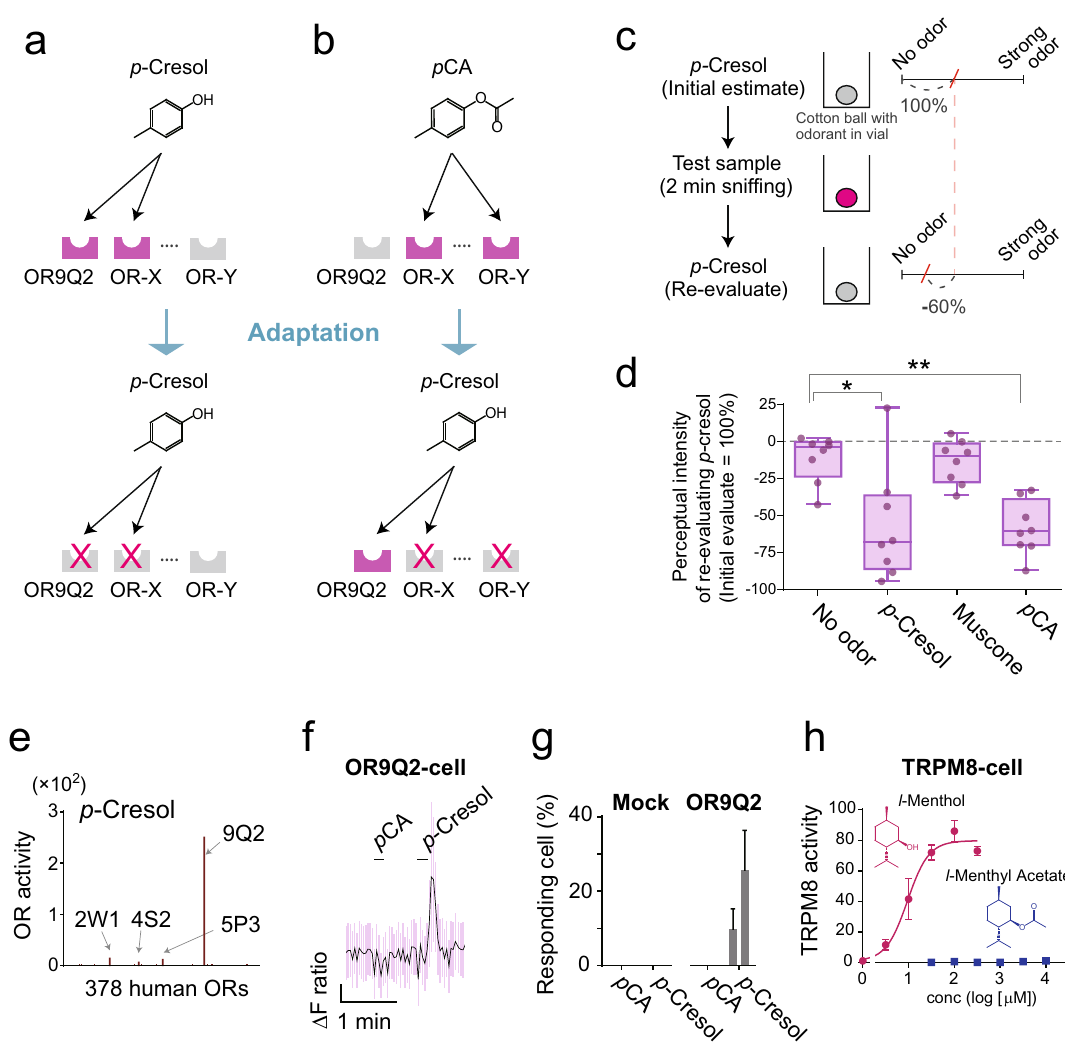
Figure 4. Effect of the enzymatic conversion on perception. ( a , b ) A model showing olfactory adaptation for p -cresol or p -cresyl acetate ( p CA) through activation and desensitization of a distinct subset of olfactory receptors (ORs). ( c ) The experimental adaptation scheme and sensory evaluation. Each subject evaluated the perceived intensity of the first bottle and the third bottle, both of which contain cotton balls saturated with p -cresol. The second bottle contained an adapting stimulus: distilled water (no odor), p -cresol, muscone, or p CA. Participants were asked to smell p -cresol and record their perceived intensity of the odor on a 95-mm scale, marked from no odor to strong odor. ( d ) Change in perceived intensity of p -cresol after prolonged exposure with each test sample (n = 8). Statistically significant changes in comparison with a control (no odor) were determined by one-way analysis of variance (ANOVA) with unequal standard deviation and Holm- Sidak’s multiple comparisons test. *, P = 0.0303; **, P = 0.0012. ( e ) Screening of human ORs for p -cresol. Each of the 378 ORs listed along the x-axis was expressed in HEK293T cells and stimulated with p -cresol (1 mM). OR activations were monitored using a CRE-regulated luciferase reporter gene assay. The y-axis indicates the fold increase of OR activity where a signal from stimulated cells is divided by that from non-stimulated cells expressing the same OR (mean values from two screening replicates). ( f , g ) Calcium imaging of OR9Q2 activation. ( f ) A representative response trace of responsive cells. The purple vertical lines around the trace represent the standard deviation from 50 cells. Horizonal lines above the trace indicate the duration of stimulations with 1 mM p CA and 0.3 mM p -cresol. ( g ) Proportion of responding cells to 0.3 mM or 1.0 mM of each odorant from three independent experiments (mean ± SE). ( h ) Dose–response curve of transient receptor potential melastatin 8 (TRPM8) activity with l -menthol and l -menthyl acetate. Calcium ion influx-dependent fluorescence in TRPM8 stably expressed in HEK293T cells was measured. The fluorescence intensity was normalized with 4 μM ionomycin. Data are from three independent experiments (mean ±